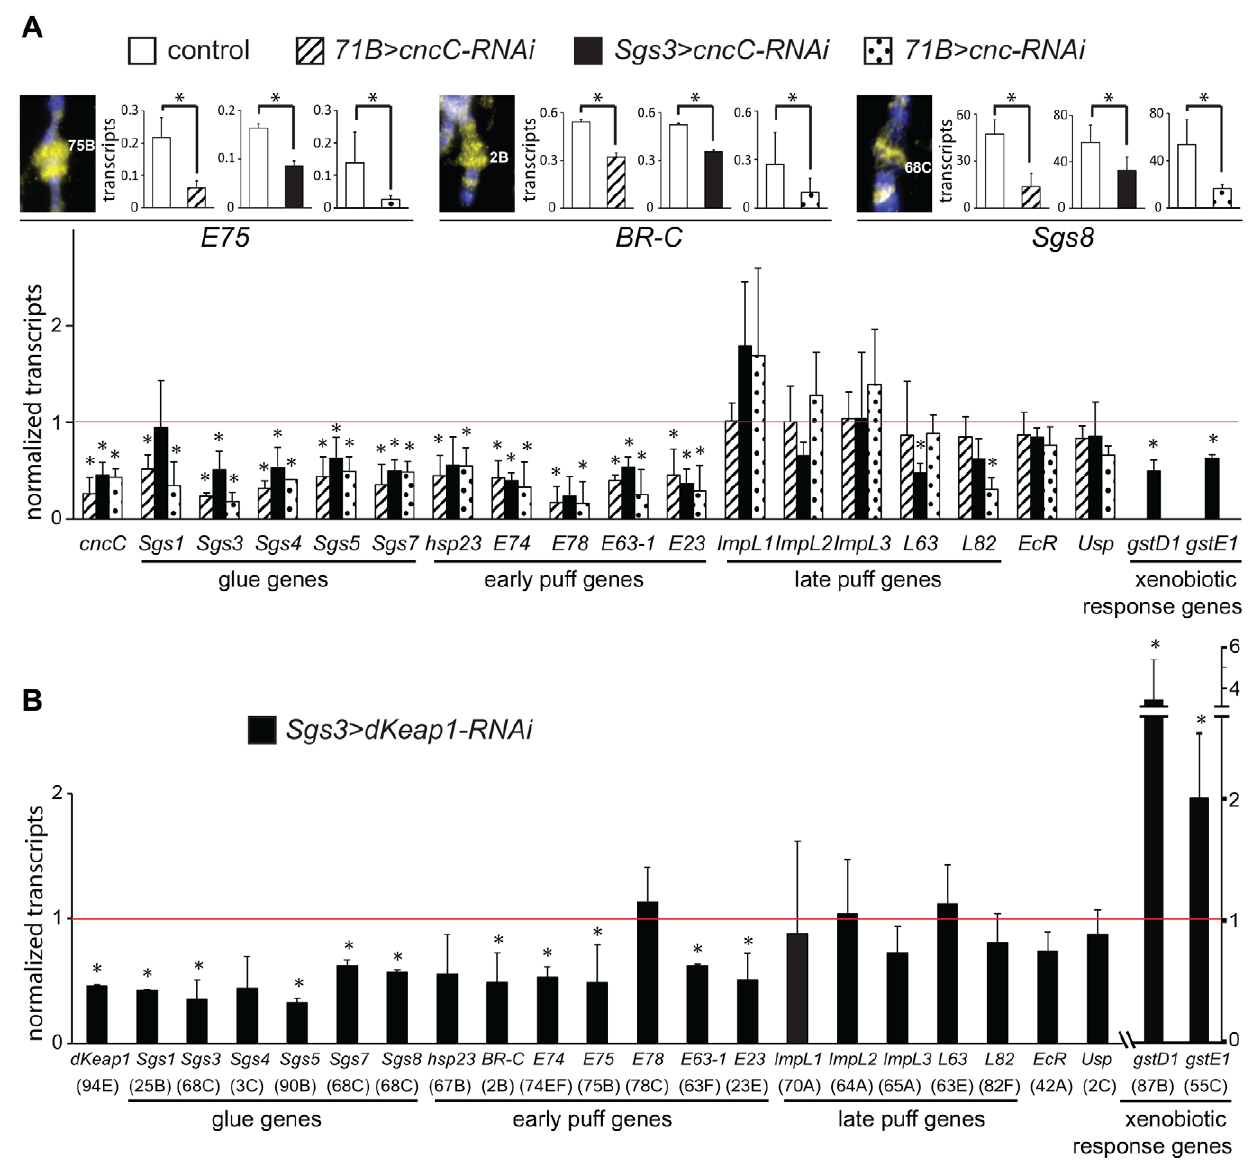
Figure 2. Regulation of early puff gene transcription by CncC and dKeap1. (A). Effects of CncC depletion in the salivary glands on the transcription of ecdysone-regulated genes and xenobiotic response genes. The images show wild type polytene chromosomes stained using anti- CncC antibodies. The levels of the transcripts indicated below the bar graphs were measured in the salivary glands of early wandering 3 rd instar larvae. Transcript levels were compared in control larvae [ 71B-GAL4 ( 71B . ), Sgs3-GAL4 ( Sgs3 . ); open bars] and in larvae that expressed the shRNA targeting CncC under the control of the 71B-GAL4 ( 71B . cncC-RNAi ; solid bars) or the Sgs3-GAL4 ( Sgs3 . cncC-RNAi ; striped bars) driver, as well as in larvae that expressed a different shRNA targeting all Cnc isoforms under the control of the 71B-GAL4 driver ( 71B . cnc-RNAi ; dotted bars). Larvae with different drivers and shRNAs were analyzed in separate experiments under different conditions (see methods). To facilitate comparison, the transcript levels in the lower graph were normalized by the levels of the transcripts in the control larvae. (B). Effects of dKeap1 depletion in the salivary glands on the transcription of ecdysone-regulated genes and xenobiotic response genes. The levels of the transcripts indicated below the bar graphs were measured in the salivary glands of early wandering 3 rd instar larvae that expressed the shRNA targeting dKeap1 under the control of the Sgs3-GAL4 driver as described for the lower graph in panel A. The data in panels A and B represent the means and standard deviations from three or four separate experiments each (*, p , 0.05). The corresponding loci are indicated in parentheses below the lower graph.